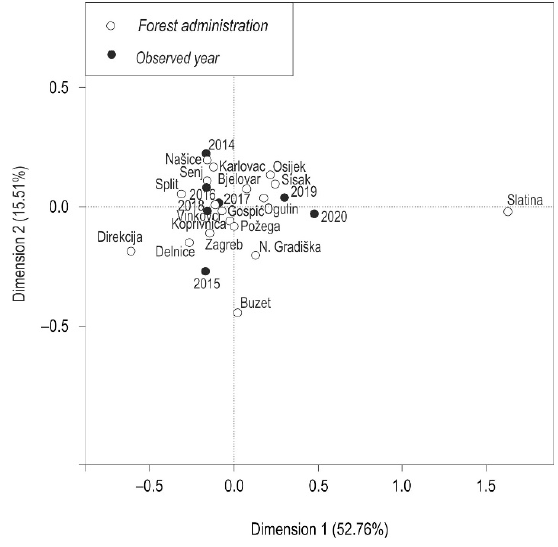
Figure 3. Correspondence analysis map for injuries in total.